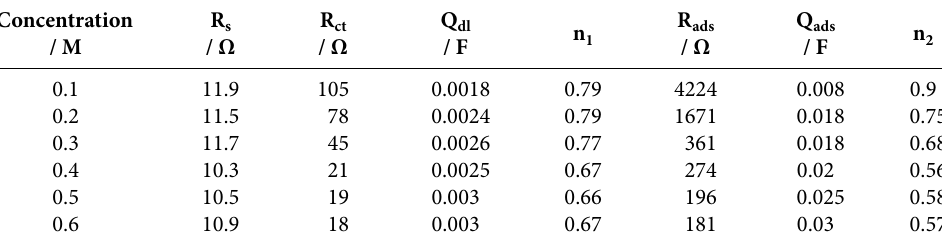
Table 1. Equivalent circuit parameters of electro-oxidation of ethanol on Ni-Cu electrode in 1 M NaOH solution. Concentration R s R ct Q dl